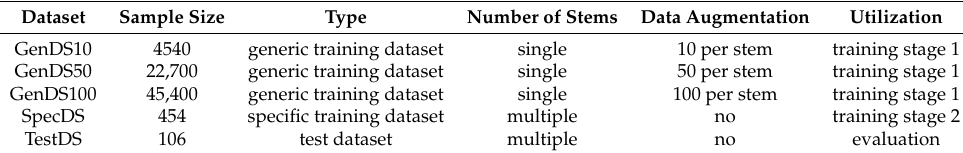
Table 1. Overview of the training and test